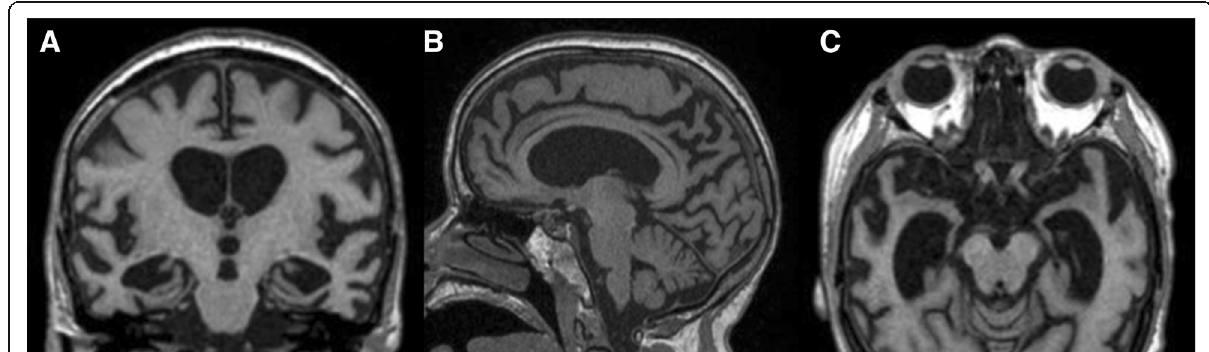
Fig. 11 Coronal ( a ), sagittal ( b ), and axial ( c ) T1/3D reconstructions of a 58-year-old Down syndrome patient presenting with new-onset myoclonic seizures and showing imaging findings similar to Alzheimer disease, with diffuse atrophy predominantly involving the temporal mesial ( a , c ) (grade 4 in the visual rating scale) and parietal structures with ex-vacuo widening of adjacent CSF spaces ( b ). The clinical and radiological picture allowed the